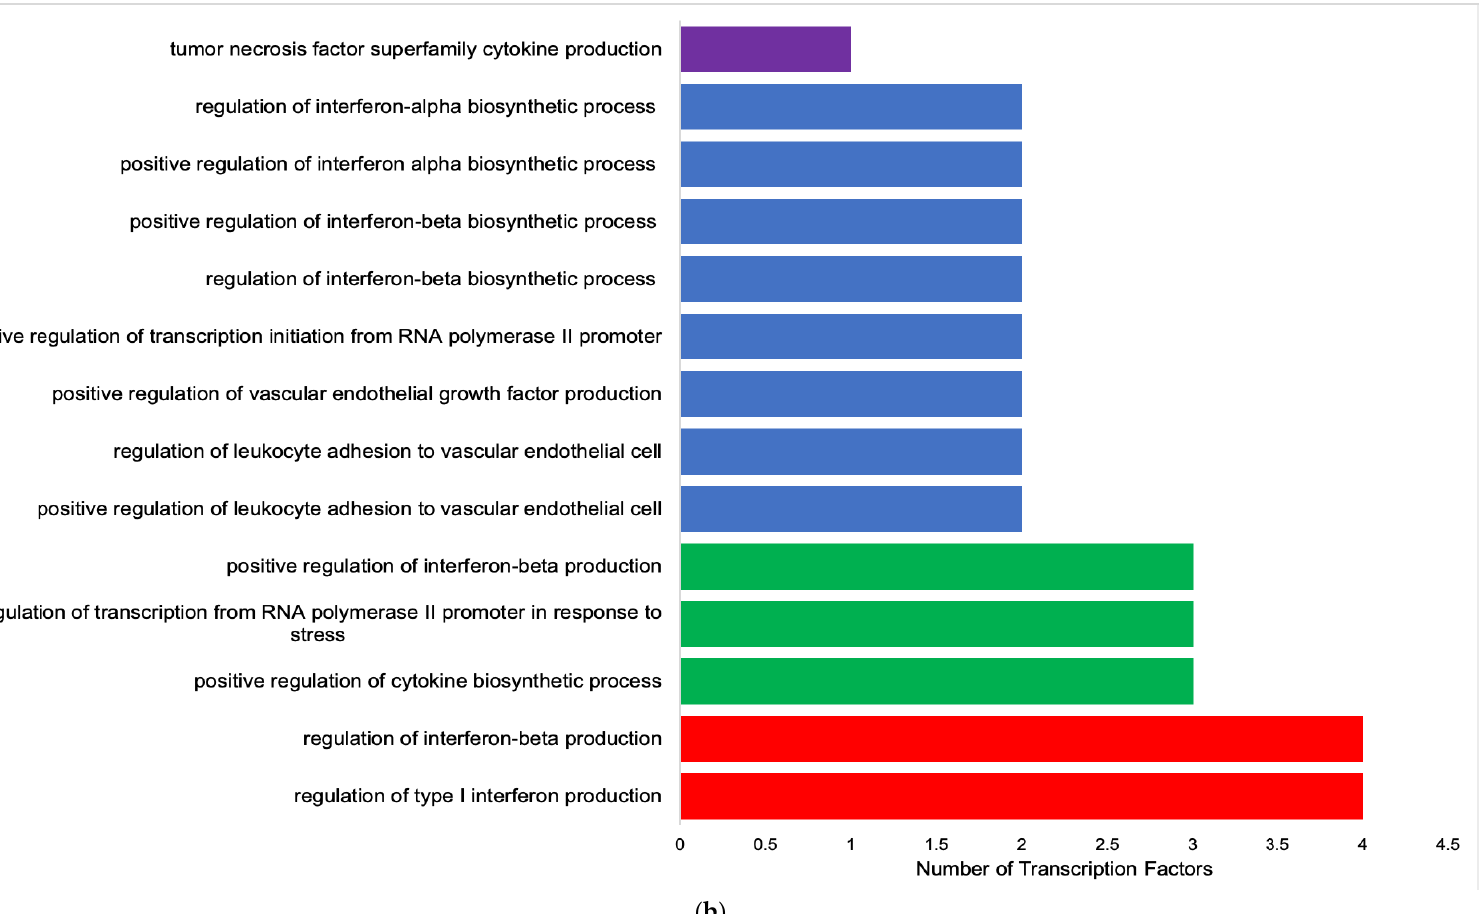
Figure 2. Pathway analysis of identified target genes and transcription factors; ( a ) Bar chart showing the number of genes or transcription factors identified for each significant pathway. Pathways with a red bar identified five genes and/or transcription factors, pathways with a green bar identified three, pathways with a blue bar identified two, and pathways with a purple bar identified one gene or transcription factor. ( b ) Bar chart showing the number of genes and transcription factors identified for each immune specific pathway. Immune specific pathways with a red bar had four genes and/or transcription factors, pathways with a green bar had three, pathways with a blue bar had two, and pathways with a purple bar had one.